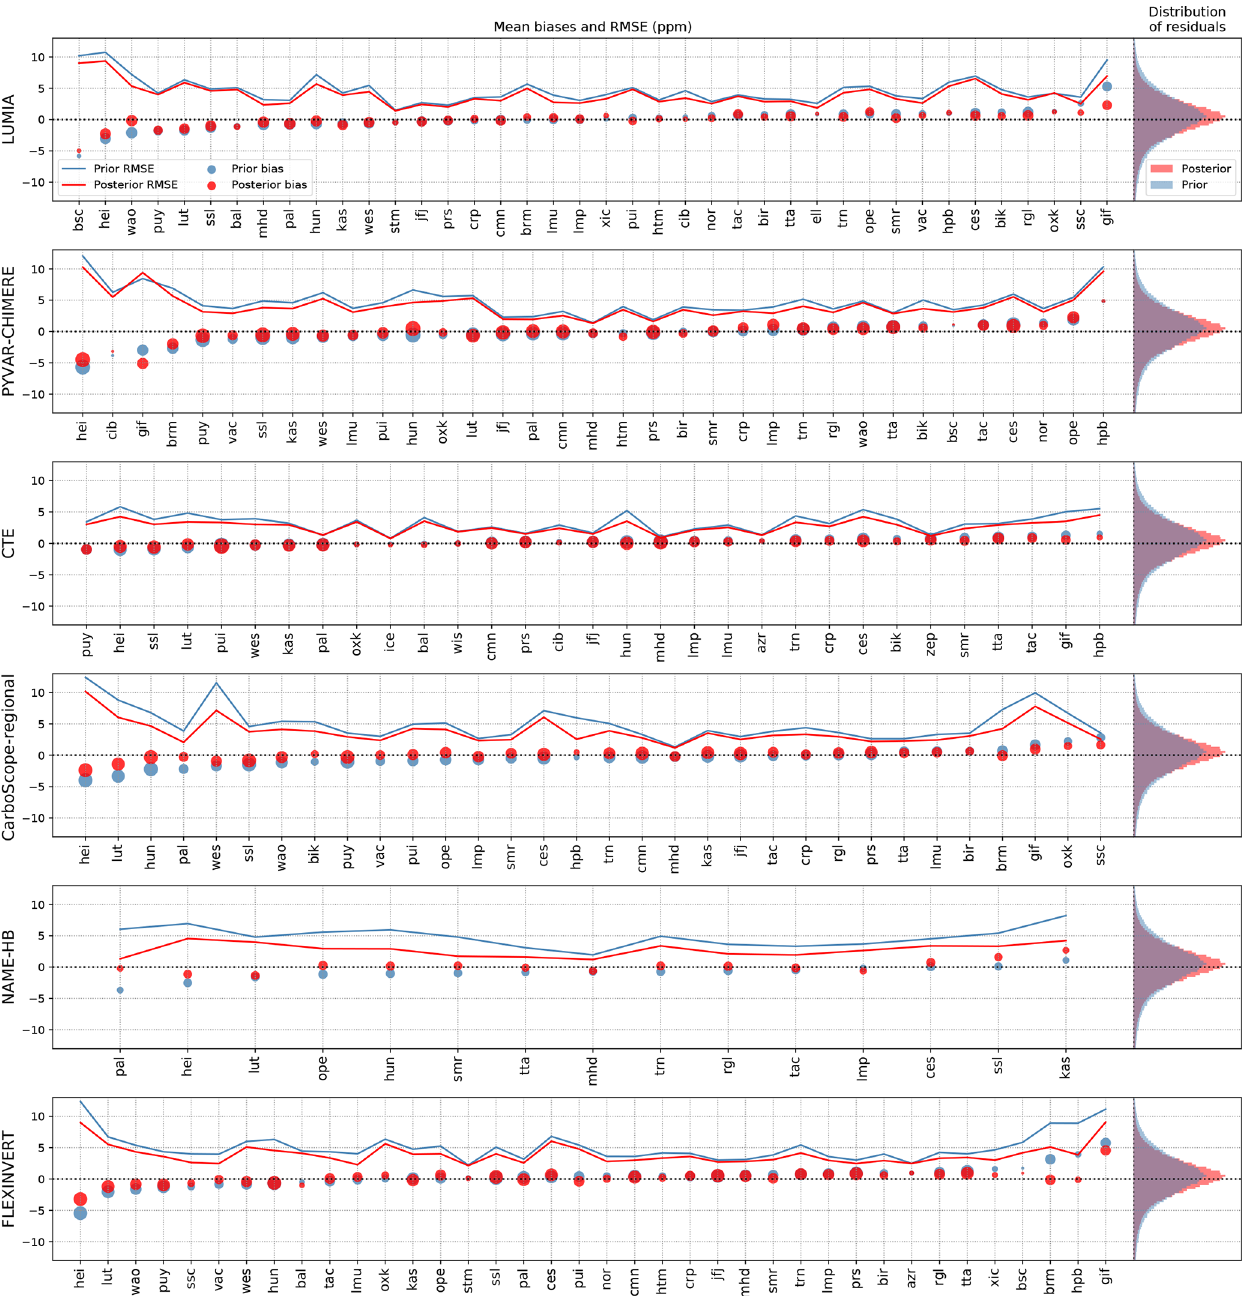
Figure 3. Prior (blue) and posterior (red) mean bias (dots) and RMSE (solid lines) at each observation site, for each inversion. The size of the dots is proportional to the number of assimilated observations. The histograms at the right of each subplot show the prior and posterior distribution of fit residuals for the entire ensembles of assimilated